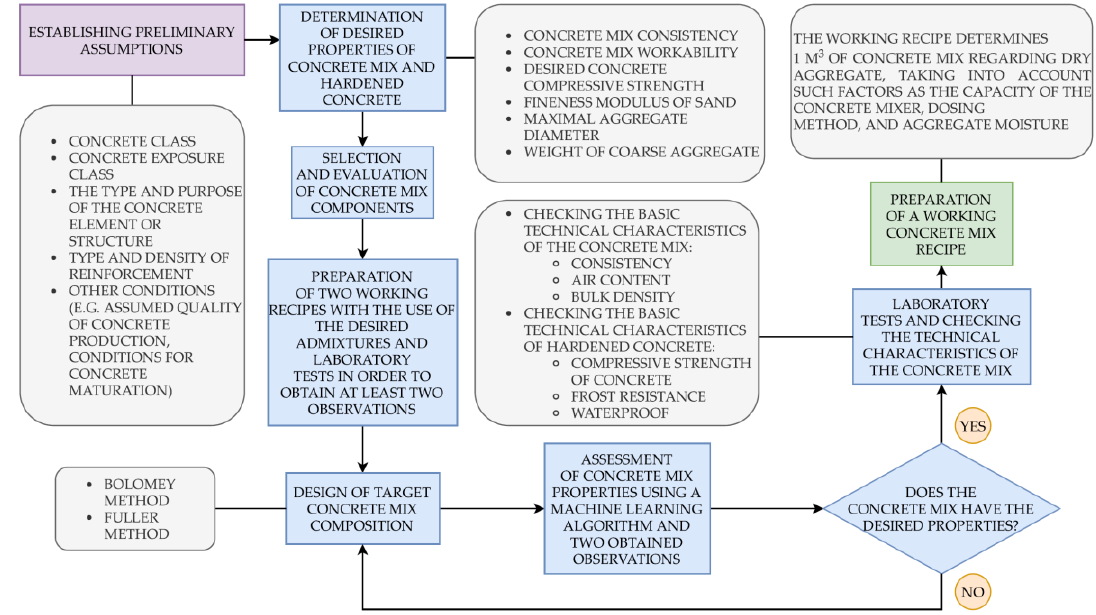
Figure 1. Flowchart presenting the practical application of the MAFM21 (Machine-learning Adaptive Forecasting Model 2021)-based formula in the concrete mix design process.